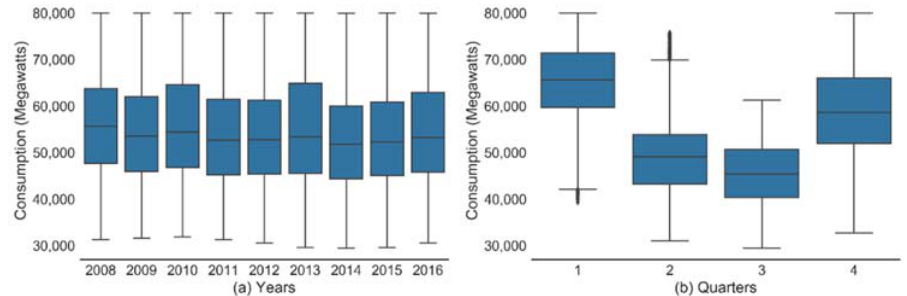
Figure 5 . Box Plot of Electric load ( a ) Yearly ( b ) Quarterly.